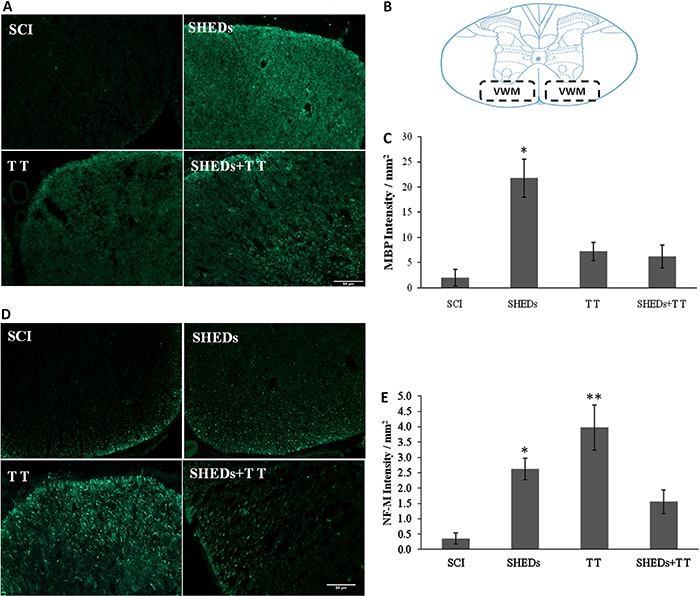
MBP staining in ventral white matter (VWM) (A), spinal regions of quantification (B), densitometry of MBP (C), spinal regions of NF-M staining in VWM (D), densitometry of NF-M (E) of spinal cord injury (SCI), SCI treated with stem cells from human exfoliated deciduous teeth (SHEDs), SCI treated with treadmill training (TT), and SCI treated with SHEDs and treadmill training (SHEDs+TT) rats. Data are reported as means±SE. *P<0.05, SHEDs group compared to SCI group. **P<0.05, TT group compared to SHEDs and SCI groups (one-way ANOVA followed by Tukey's post hoc test). Scale bar = 50 µm.